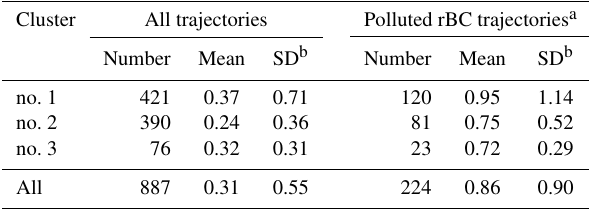
Table 1. Trajectory clusters and mean refractory black carbon (rBC) concentration for each